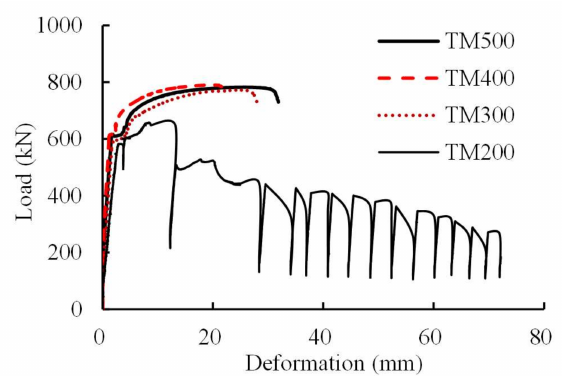
Figure 8. Load-deformation curves for Specimens MT500, MT400, MT300, and MT 200.